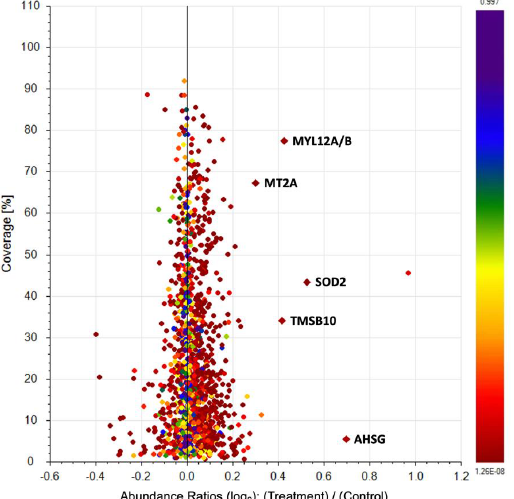
Figure 11. Scatter plots showing the percentage of protein sequence coverage vs. their Log 2 fold change abundance value in HGF cells after 24 h treatment with EgPs . Proteins were ranked accord- ing to their p -value from red to blue. Proteins with p -value < 0.05 and Log 2 fold change > 0.3 are drawn in diamonds showing their gene symbol. Table 4. Significantly overexpressed proteins in HGF cells after treatment with EgPs.